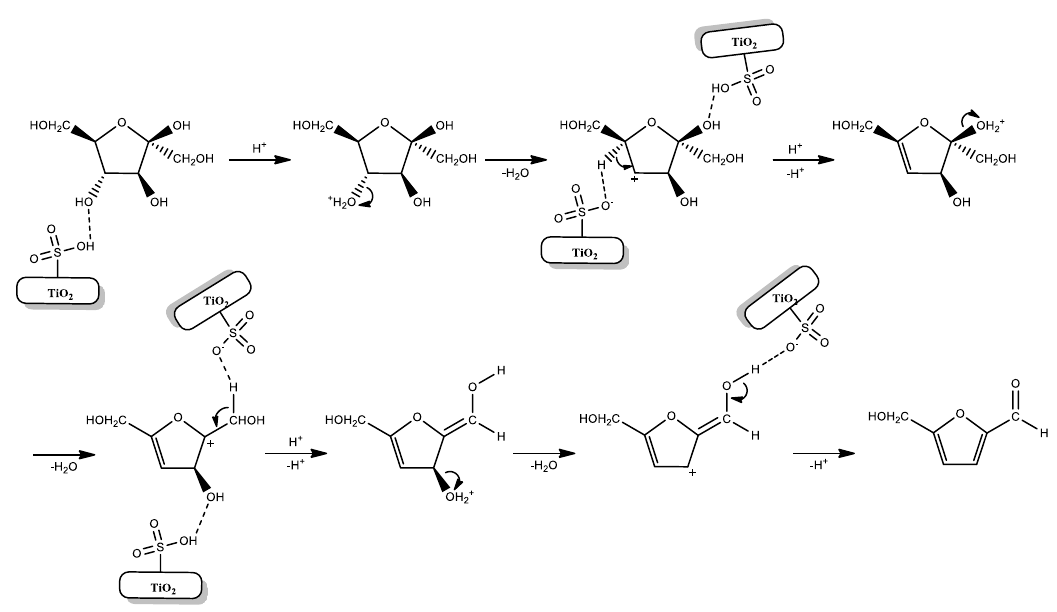
Figure 8. Proposed mechanism of fructose dehydration to HMF over TiO 2 – SO 3 H.